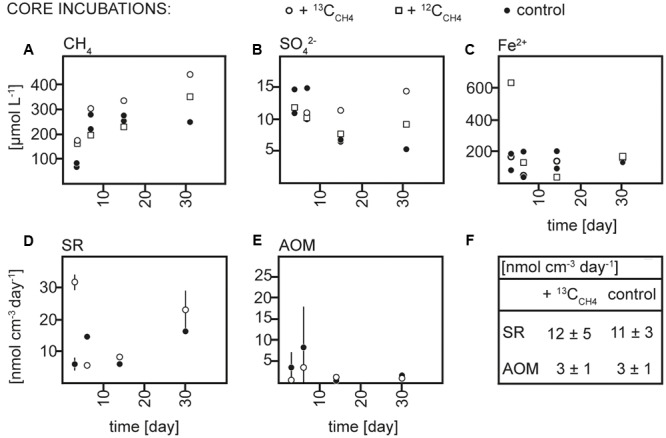
Concentrations over time of (A) methane (CH4), (B) sulfate (SO42-), and (C) dissolved iron (Fe2+), rates over time of (D) sulfate reduction (SR) and (E) anaerobic methane oxidation (AOM) in 13CCH4, 12CCH4 and control core incubations and (F) average rates of SR and AOM in 13CCH4 and control core incubations.